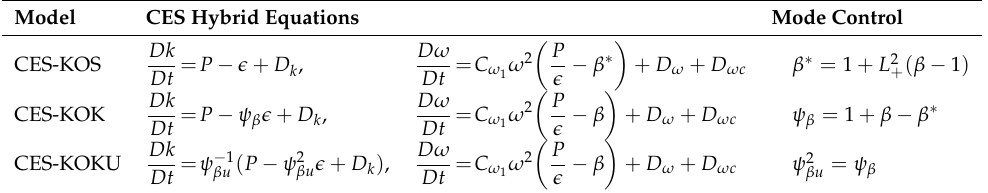
Table 1. Overview of CES models considered in [17]. CES-KO refers to CES performed with the k − ω model. In particular, -KOS (-KOK, -KOKU) refer to CES-KO performed by modifying the scale equation (the k equation, the turbulent time scales in the k equation according to unified RANS-LES). Model CES Hybrid Equations Mode Control